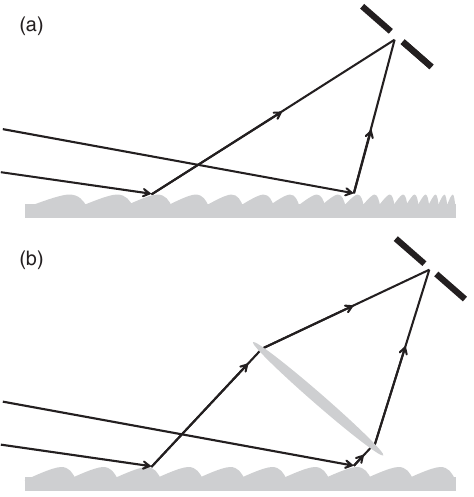
FIG. 4. Schematic diagram of a VLS grating element. The VLS grating (a) is represented by a contribution of a planar grating with fixed line spacing and a thin lens